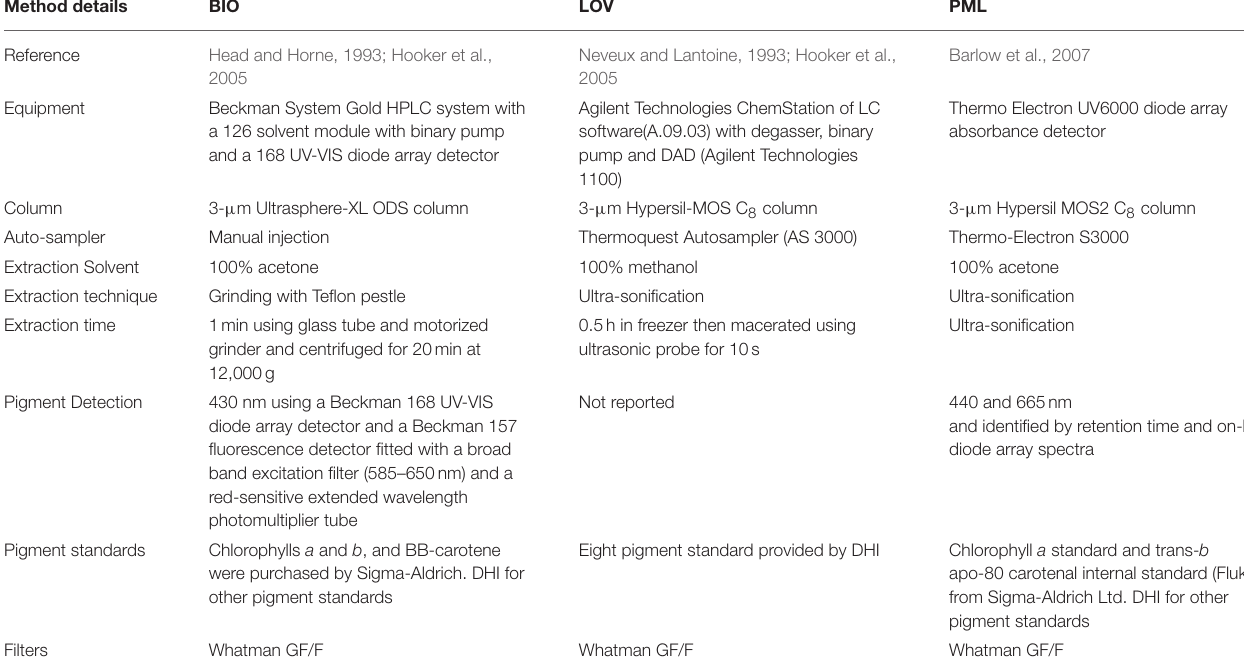
TABLE 1 | Summary of HPLC